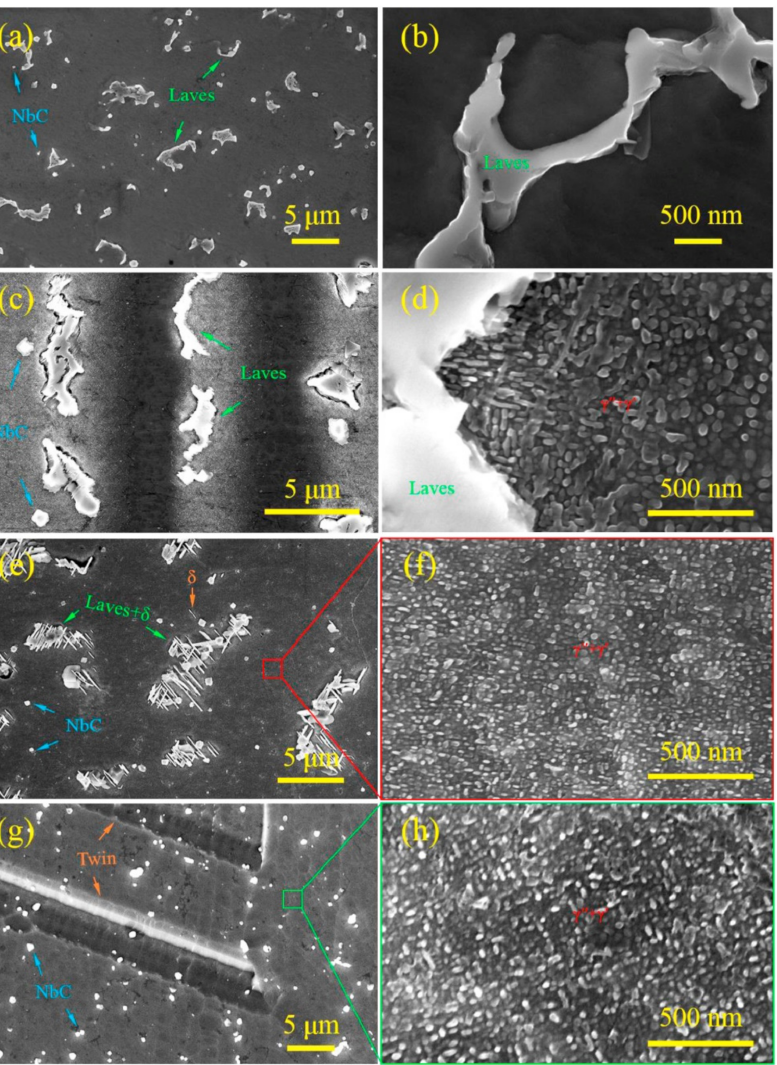
Figure 4. SEM images. ( a , b ) As-manufactured. ( c , d ) direct aging. ( e , f ) solution treatment plus aging. ( g , h ) homogenization plus solution treatment plus aging. (Reprinted with permission from ref. [88]. Copyright 2020